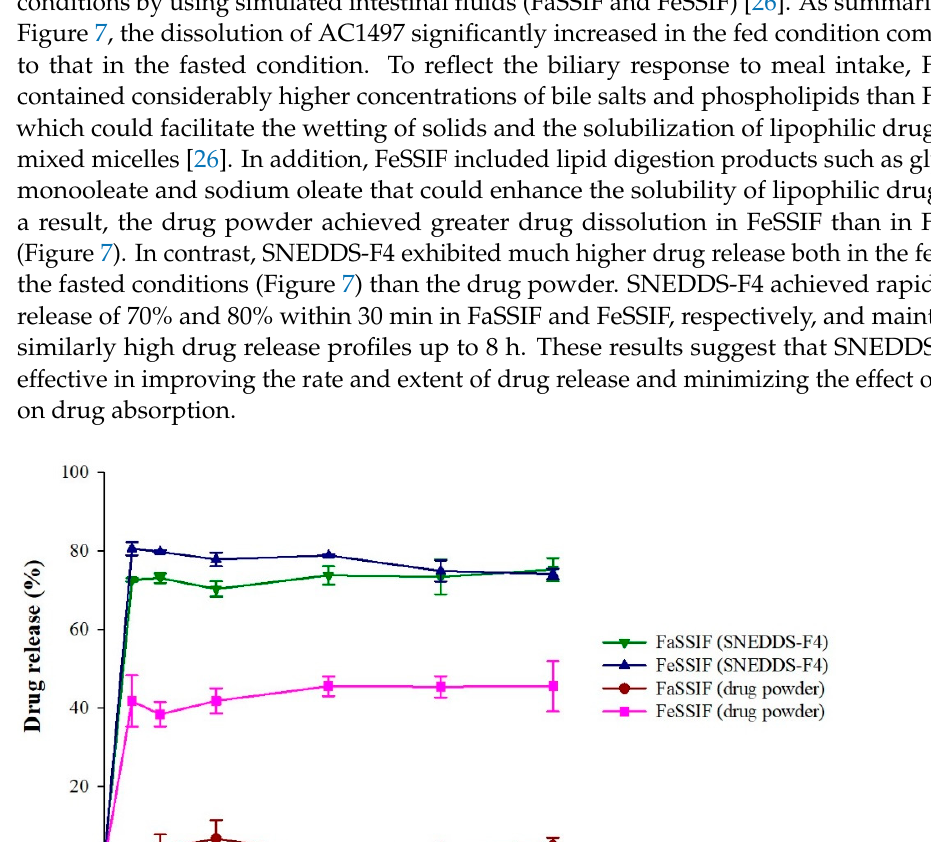
Figure 6. Drug release profiles of SNEDDS-F4 (mean ± SD, n = 3). ( A ) Comparison of SNEDDS-F4 and drug powder in water, ( B ) drug release profiles of SNEDDS-F4 at different pH conditions.